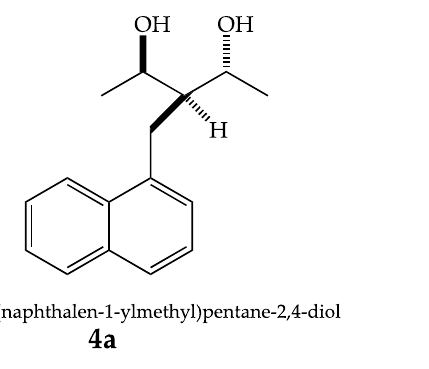
Figure 1. Absolute configuration of compounds 4a and 4b .